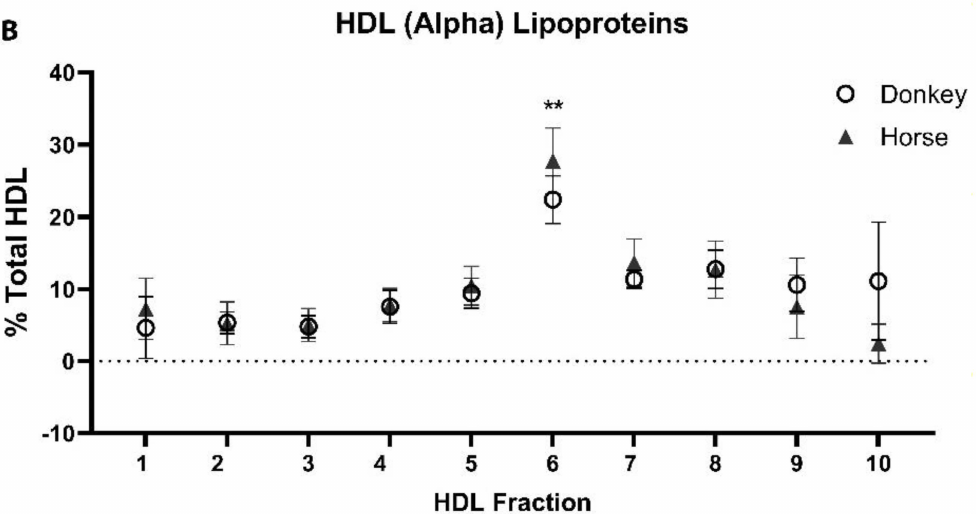
Figure 4. Summative data of LDL Lipoprint ® fractionation ( A ) and HDL Lipoprint ® fractionation ( B ). Data are depicted as the means and standard deviations. AUC, area under the curve. C, B, and A indicate the mid0fractions between VLDL and LDL. The remaining numbers are the numerical subfraction of the major lipoprotein class. ** p < 0.01, *** p < 0.001